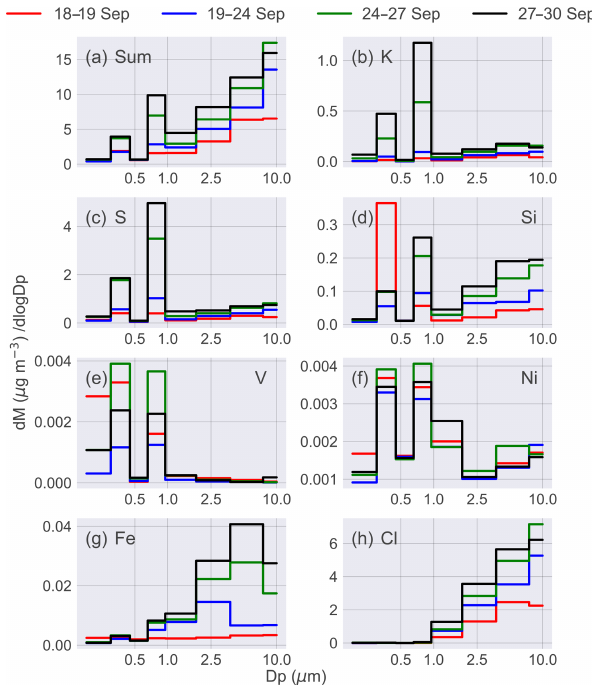
Figure 3. Time evolution of mass size distributions over the cruise period: (a) sum of all measured elements, (b) potassium, (c) sulfur, (d) silicon, (e) vanadium, (f) nickel, (g) iron, and (h) chlorine. The time periods are colored as follows: 18–19 September (red), 19–24 September (blue), 24–27 September (green), and 27–30 September (black). Stage numbers are shown in (a)